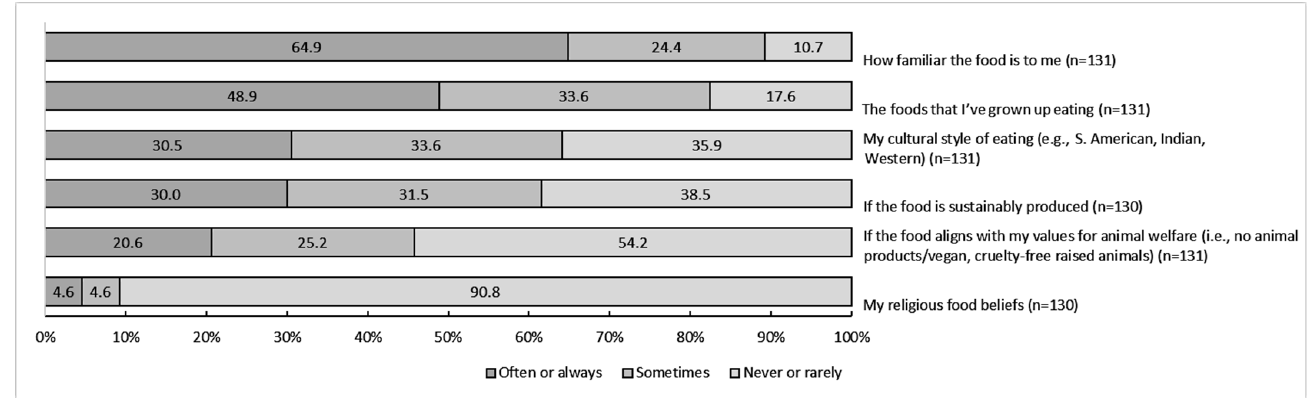
Figure 2. The proportion of 131 athletes rating how frequently (never/rarely, sometimes, and often/always) 6 indicator items from the factors’ ‘usual eating practices’ and ‘food values and beliefs’ influence their food choices.